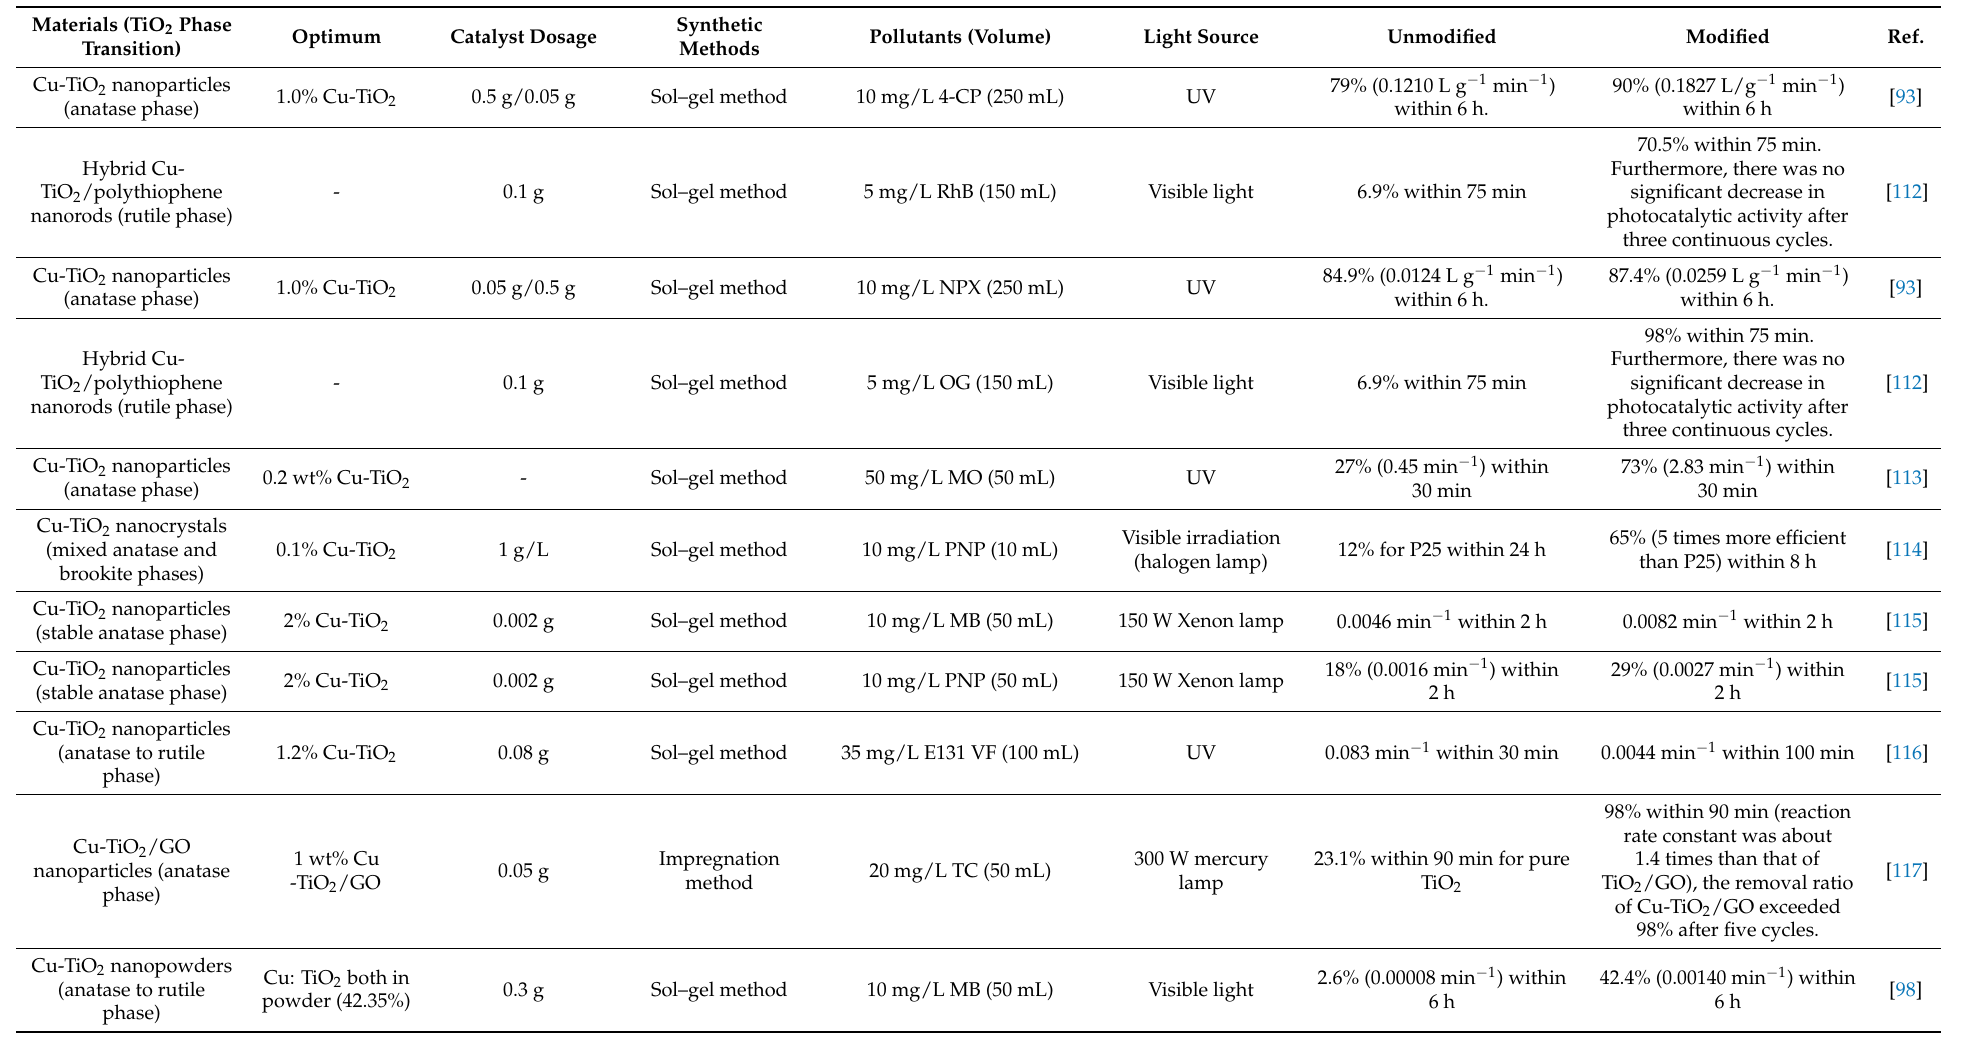
Table 5. Summary of recent progress on Cu-TiO 2 photocatalysts for organic pollutants